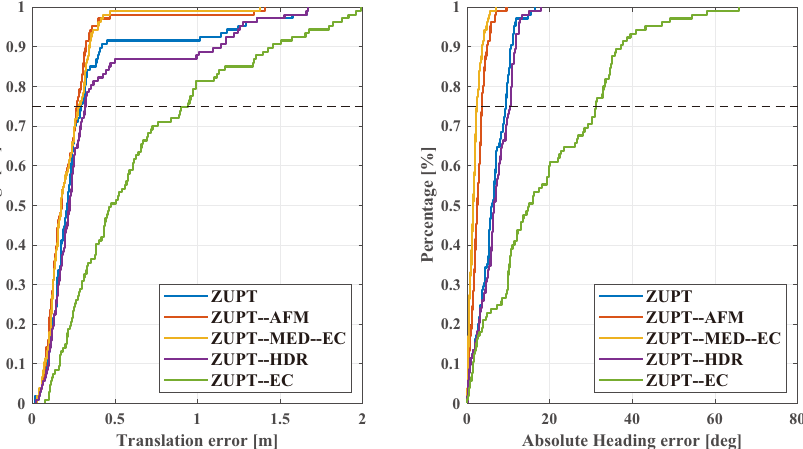
Figure 8. Translation error ( left ) and absolute heading error ( right ) cumulative distribution function (CDF) curves of different